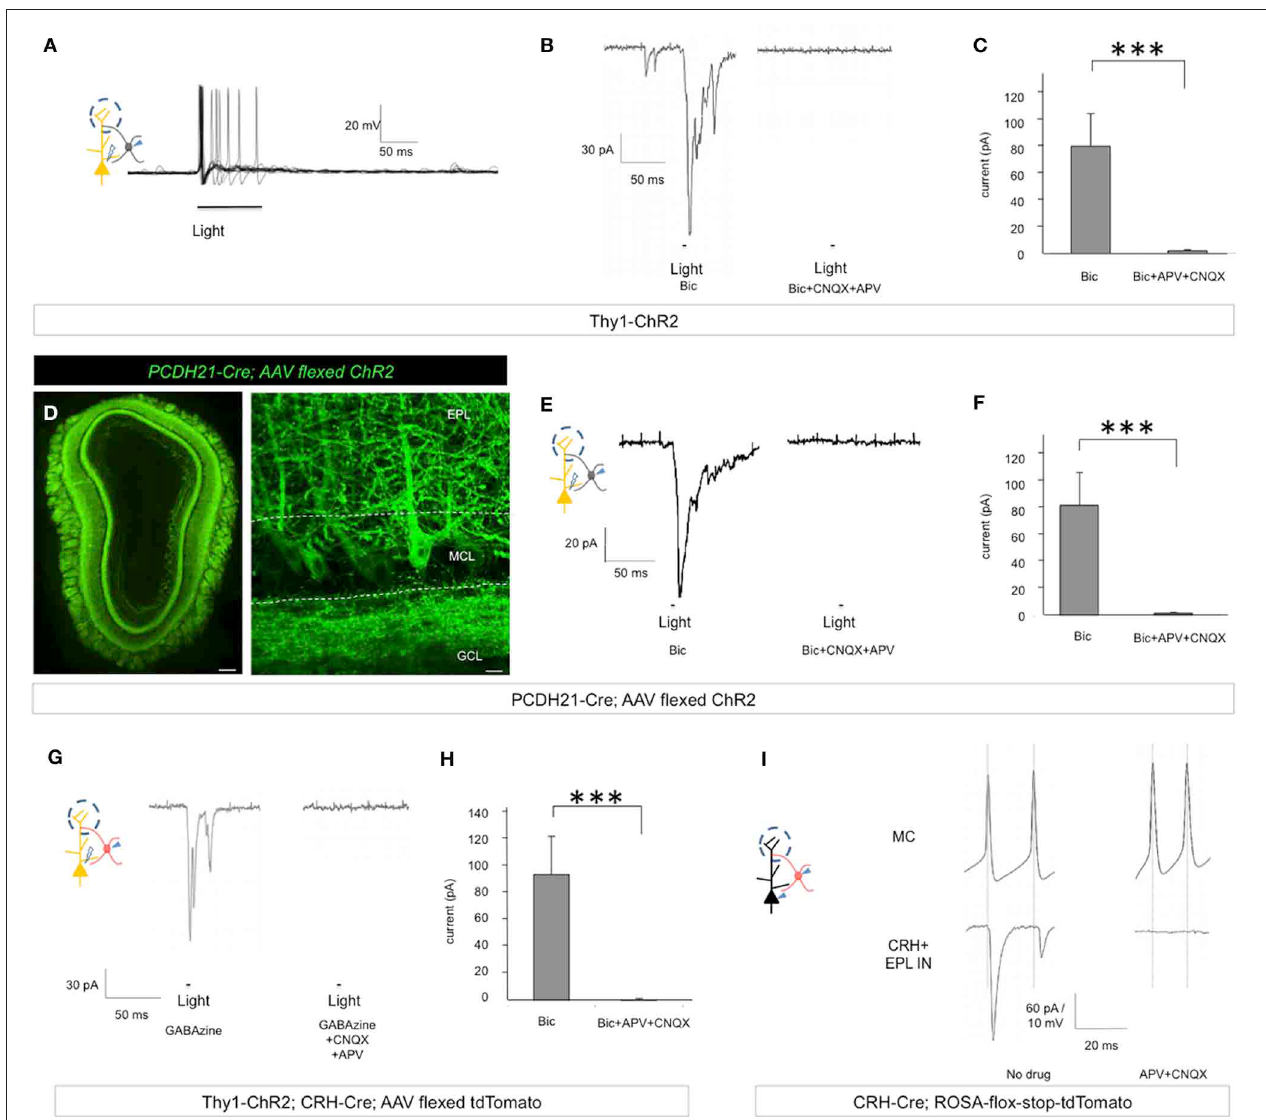
FIGURE 8 | Mitral cells make excitatory connections onto EPL interneurons. (A) Postsynaptic firing response and action potential generation in EPL interneurons following light-induced activation of mitral cells. Trace represents an overlay of 10 sweeps from a single recorded EPL from a Thy1-ChR2 mouse. (B) Left, EPL interneuron excitatory postsynaptic current in response to light-activation of mitral cells in the presence of Bicuculline in Thy1-ChR2 mice. Right, photo-responses can be blocked by APV + CNQX. (C) Peak amplitudes of light-evoked postsynaptic currents in EPL interneurons in the presence or absence of glutamatergic blockers in Thy1-ChR2 mice. Bic, n = 9; Bic + APV + CNQX, n = 8. Student’s t -test, ∗∗∗ p < 0 . 01. Bic, Bicuculline. Error bars represent SEM. (D) Conditional ChR2 expression 12d post-injection of an AAV-encoding flexed ChR2 into PCDH21-Cre mice. ChR2 is expressed in mitral cells of the olfactory bulb. Left, epifluorescence microscope image, scale bar, 200 μ m. Right, confocal microscope image showing a high magnification view of conditional AAV-ChR2 expression selectively in mitral cell membranes. The images are from coronal sections. Scale bar, 20 μ m. EPL, external plexiform layer; MCL, mitral cell layer; GCL, granule cell layer. (E) Left, EPL interneuron